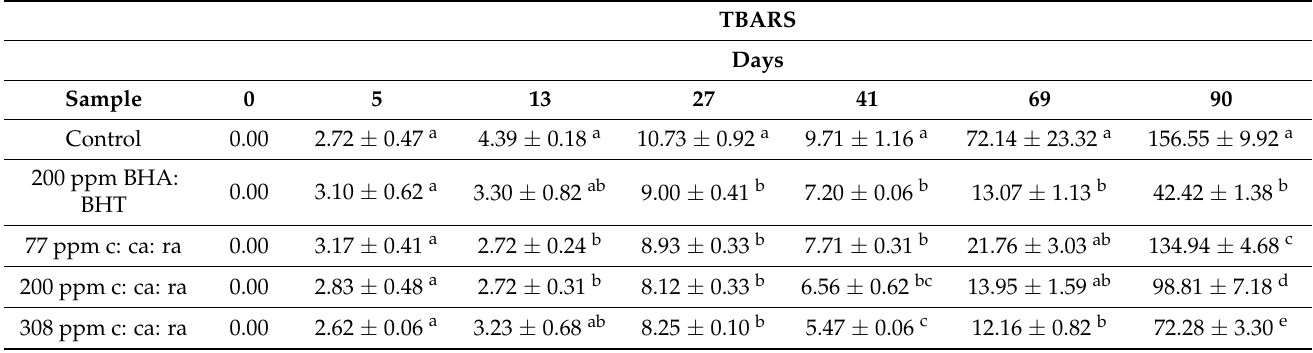
Table A2. TBARS of the FFMPs before and after accelerated storage (40 ◦ C, RH 23%), with or without the addition of antioxidants 1, 2, 3, 4 .